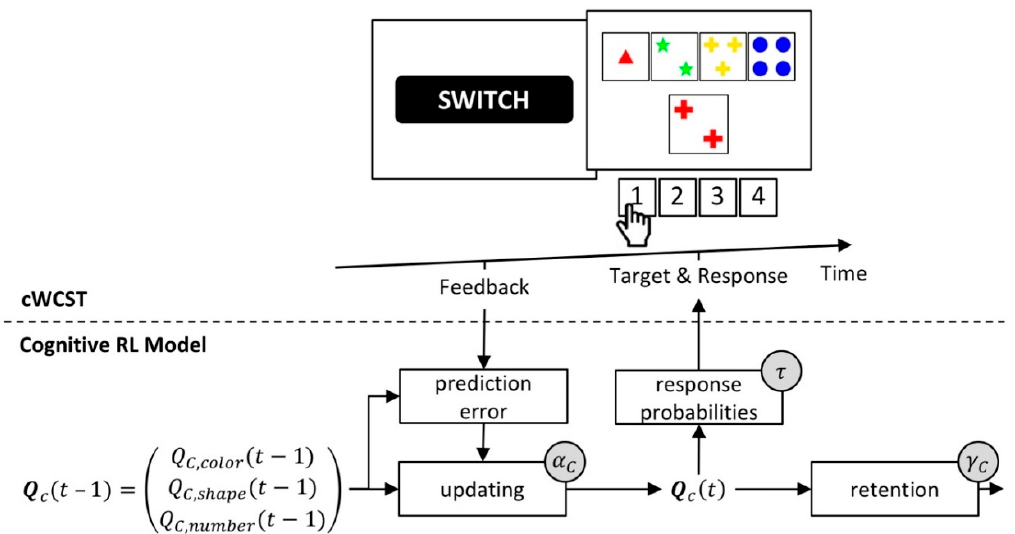
Figure 5. A schematic representation of the cognitive reinforcement-learning (RL) model. Top: an exemplary sequence on a computerized WCST. Bottom: core to the cognitive RL model are feedback predictions for the application of categories, Q c ( t ). A prediction error updates feedback predictions from the previous trial Q c ( t − 1) following received feedback. Individual cognitive learning rates α c quantify the strength of the updating of feedback predictions by prediction errors. There are separate individual cognitive learning rates for received positive and negative feedback (not depicted). A soft-max rule gives response probabilities as a function of updated feedback predictions. The individual inverse temperature parameter τ quantifies how well response probabilities accord to updated feedback predictions. A retention mechanism gives the extent to which feedback predictions transfer to the next trial. The individual cognitive retention rate γ c quantifies the strength of retention of feedback predictions.